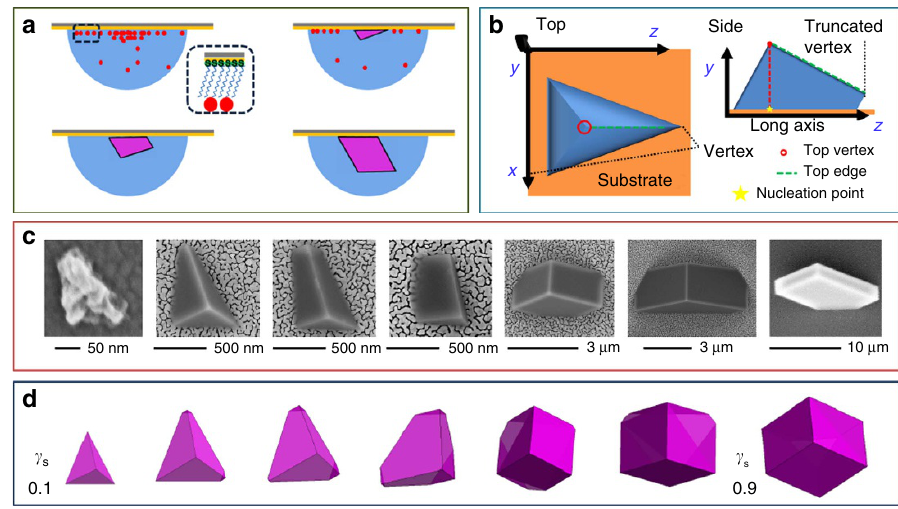
Figure 1 | Morphological progression of calcite nucleated on COOH terminated SAMs. ( a ) A schematic of the experimental set-up, where CO 2 and NH 3 diffuse into hanging droplets of CaCl 2(aq) , causing amorphous calcium carbonate formation (red dot). An oriented tetrahedron of calcite bounded by planar {104} faces then forms, whose growth leads to the development of an additional facet as a truncation of the long axis. Further growth then results in a transformation to rhombohedral calcite. ( b ) Schematic images of the tetrahedral growth form, showing the location of the truncation face. ( c ) Scanning electron microscope images showing the morphological development of the calcite crystals. ( d ) Winterbottom reconstructions predicting the morphological development of the calcite crystals, where these are of identical volume with stepwise increasing relative interfacial energy of the crystal/SAM ( g s ; 0.1–0.9). Crystal/ water interfacial energy values used were taken from Duffy and colleagues 36